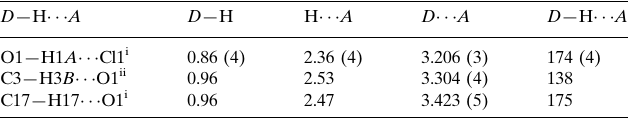
Hydrogen-bond geometry (A˚ , (cid:3)